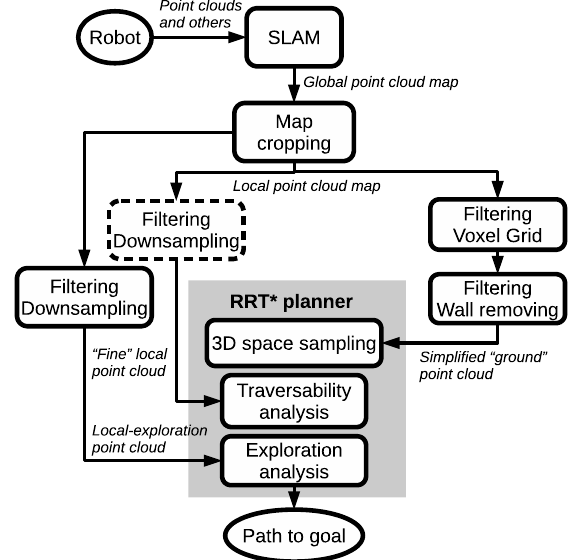
Figure 1. General diagram of the exploration and path planning system.